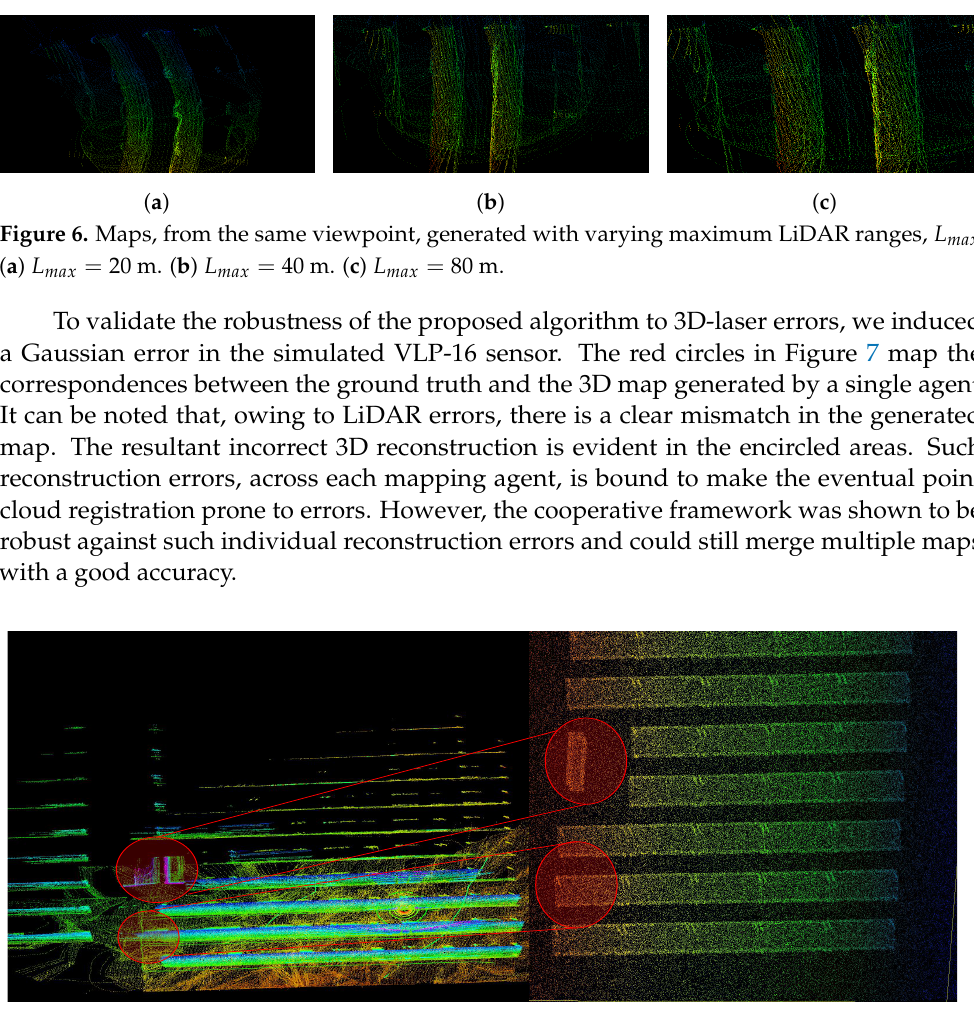
Figure 7. The effect of erroneous LiDAR measurements. The red circles represent the expected correspondences between the generated map and the ground truth. ( Left ): The LOAM-mapping result of an agent. ( Right ): The ground-truth 3D